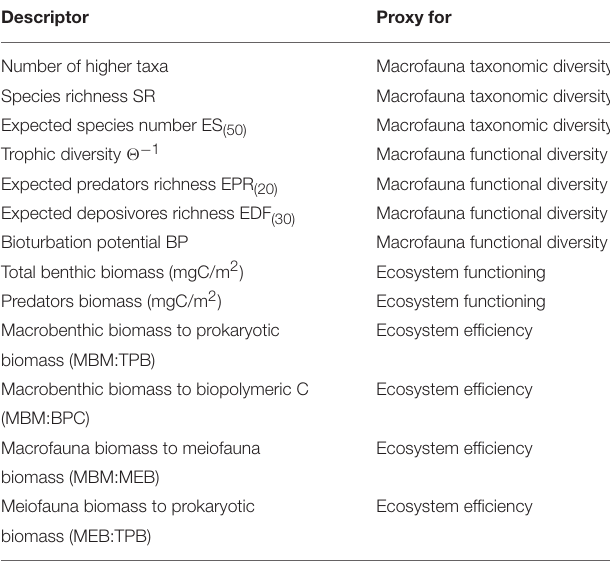
TABLE 1 | List of macrofaunal structural and functional diversity proxies and ecosystem functioning and efficiency proxies used in the present